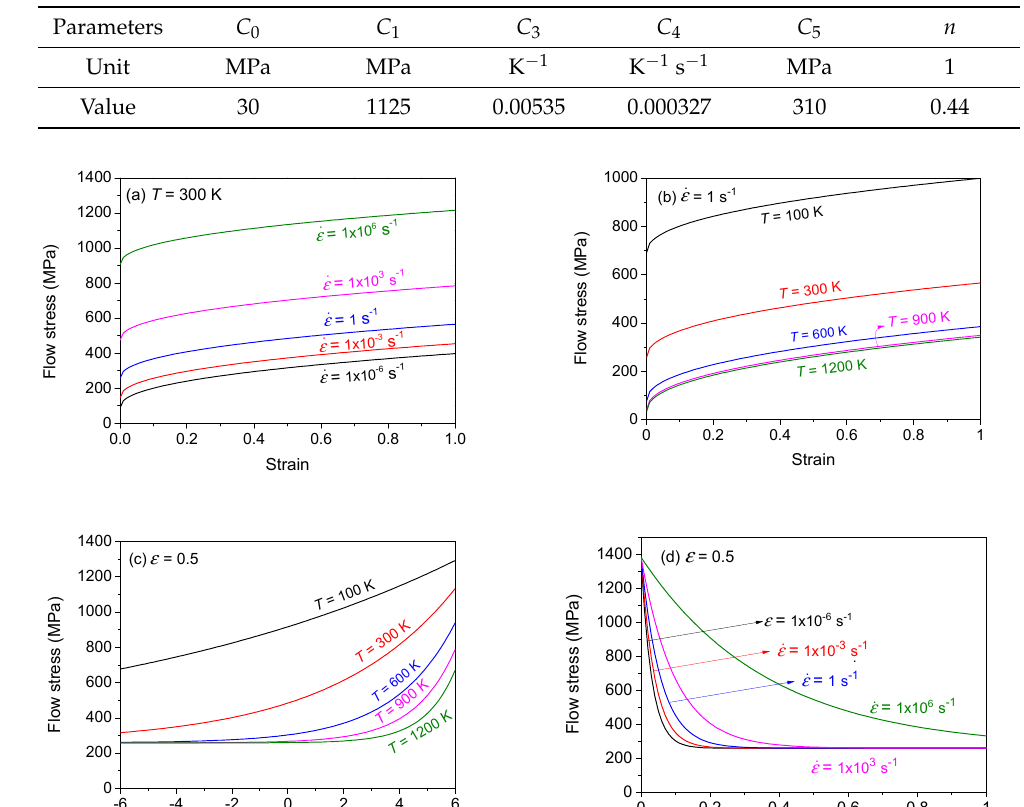
. ε ∗ = 1 s − 1 , T m = 3290 K) [18].